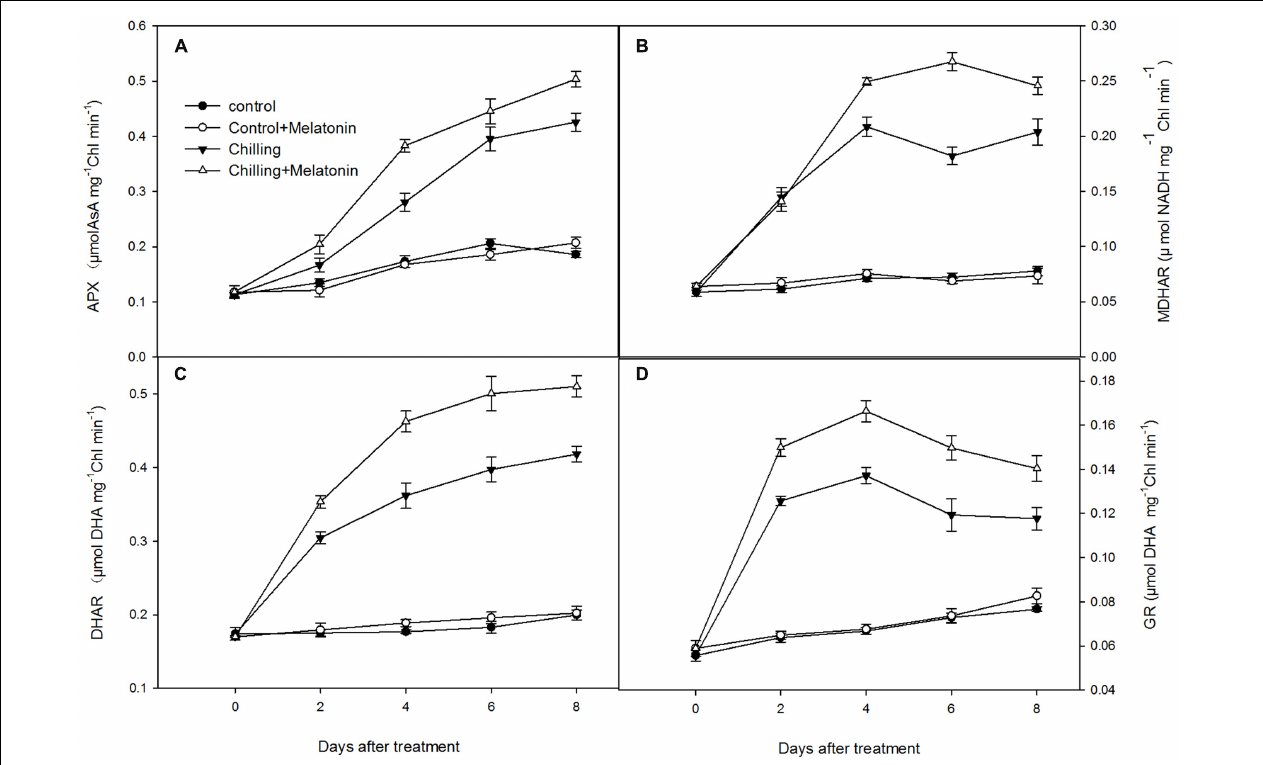
FIGURE 7 | Effects of exogenous melatonin on activities of key enzymes in ascorbic acid – glutathione (AsA–GSH) cycle in chloroplasts under chilling stress. (A) ascorbate peroxidase (APX), (B) monodehydroascorbate reductase (MDHAR), (C) dehydroascobate reductase (DHAR), (D) glutathione reductase (GR). Control (28/18 ◦ C); Control + Melatonin (200 µ M melatonin, 28/18 ◦ C); Chilling (15/8 ◦ C); Chilling + Melatonin (200 µ M melatonin, 15/8 ◦ C). Data are means ± SD of three